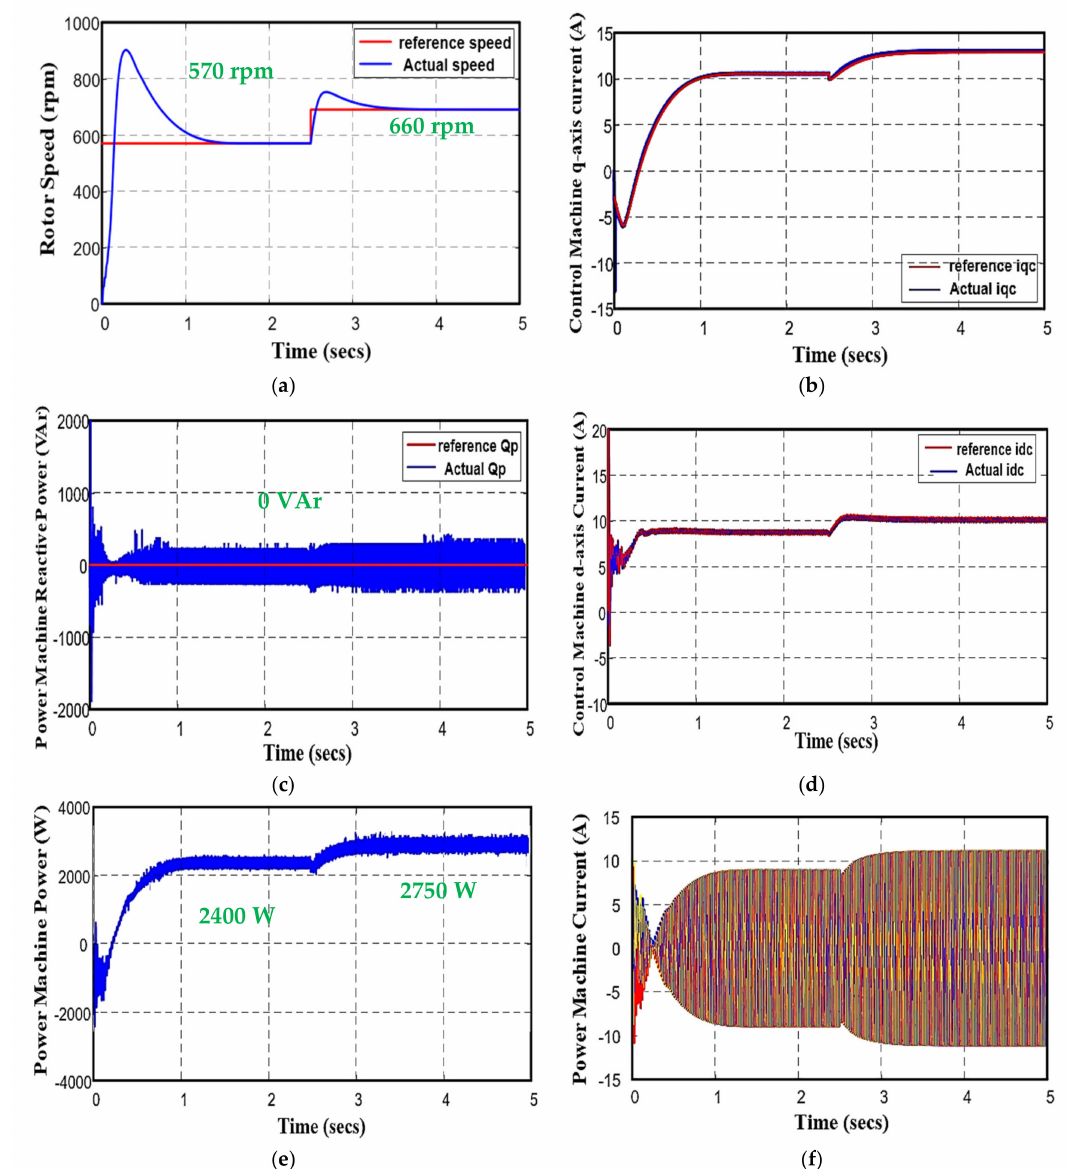
Figure 9. System performance under variable speed command and constant reactive power reference: ( a ) rotor speed, N m (rpm), ( b ) control machine q -axis current reference and actual, i qc * and i qc , ( c ) power machine reactive power, Q p , ( d ) control machine d -axis current reference and actual, ( e ) power machine active power, P p , ( f ) power machine current, I abc